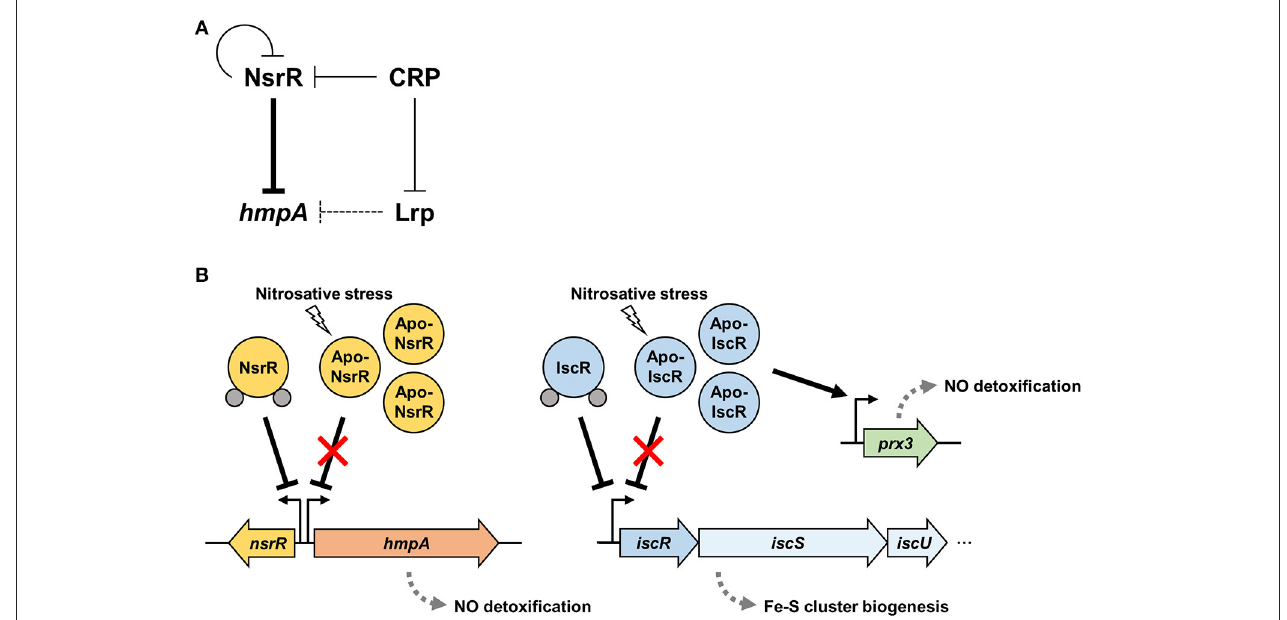
FIGURE 8 | A regulatory network controlling hmpA transcription and nitrosative stress defense systems in V. vulnificus . (A) A regulatory network comprising transcriptional regulators NsrR, Lrp, and CRP controls the hmpA transcription. NsrR directly represses hmpA and nsrR itself. Lrp indirectly represses